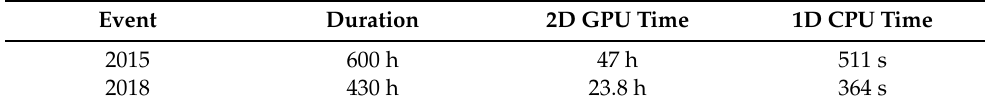
Table 1. Comparison of computational times for the two flood events simulated in the Ebro River.